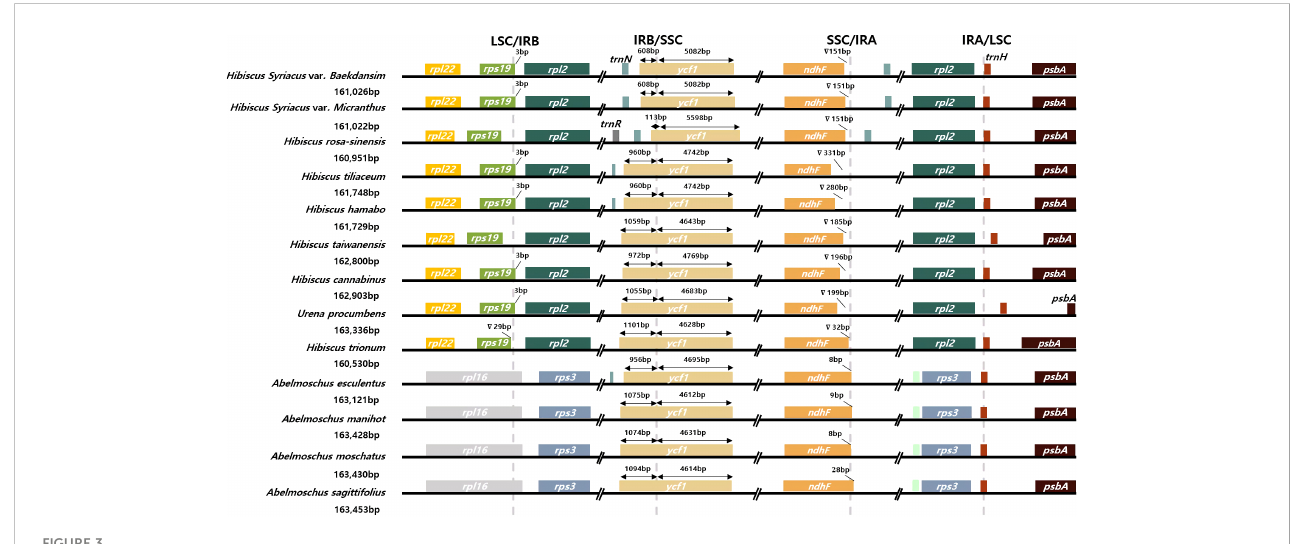
FIGURE 3 Comparison of the junction sites among 13 species of the tribe